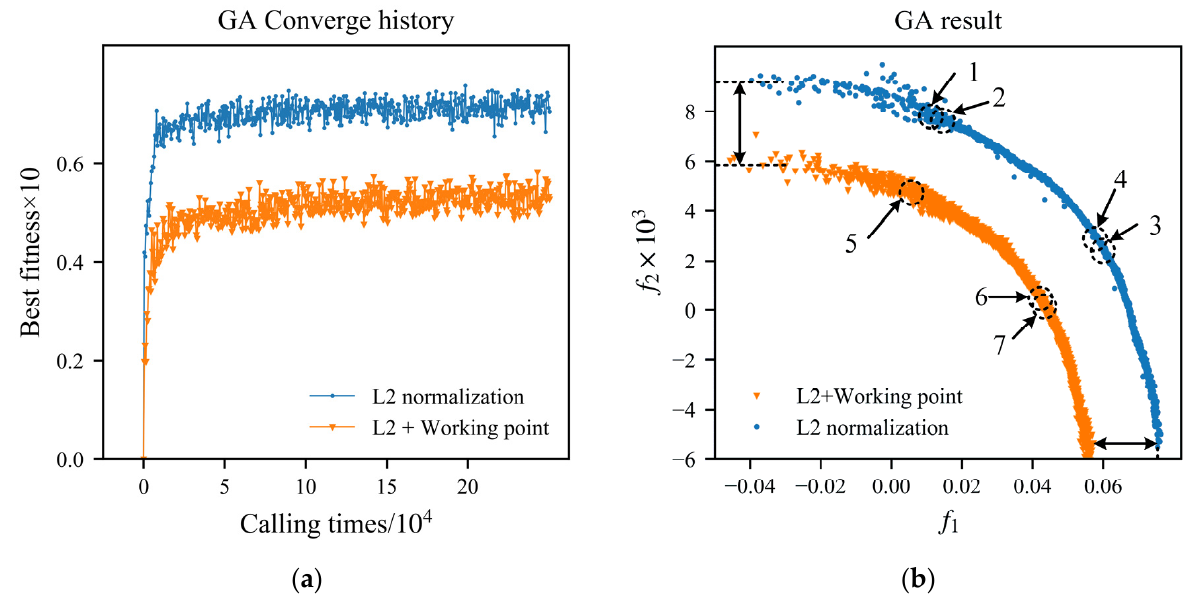
Figure 11. Evolution of the rotors using NSGA-II. ( a ) Convergence history. ( b ) Pareto front.